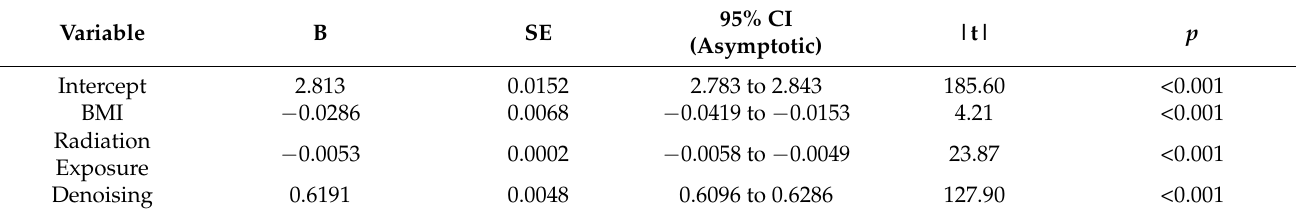
Table 3. Objective image quality analysis.